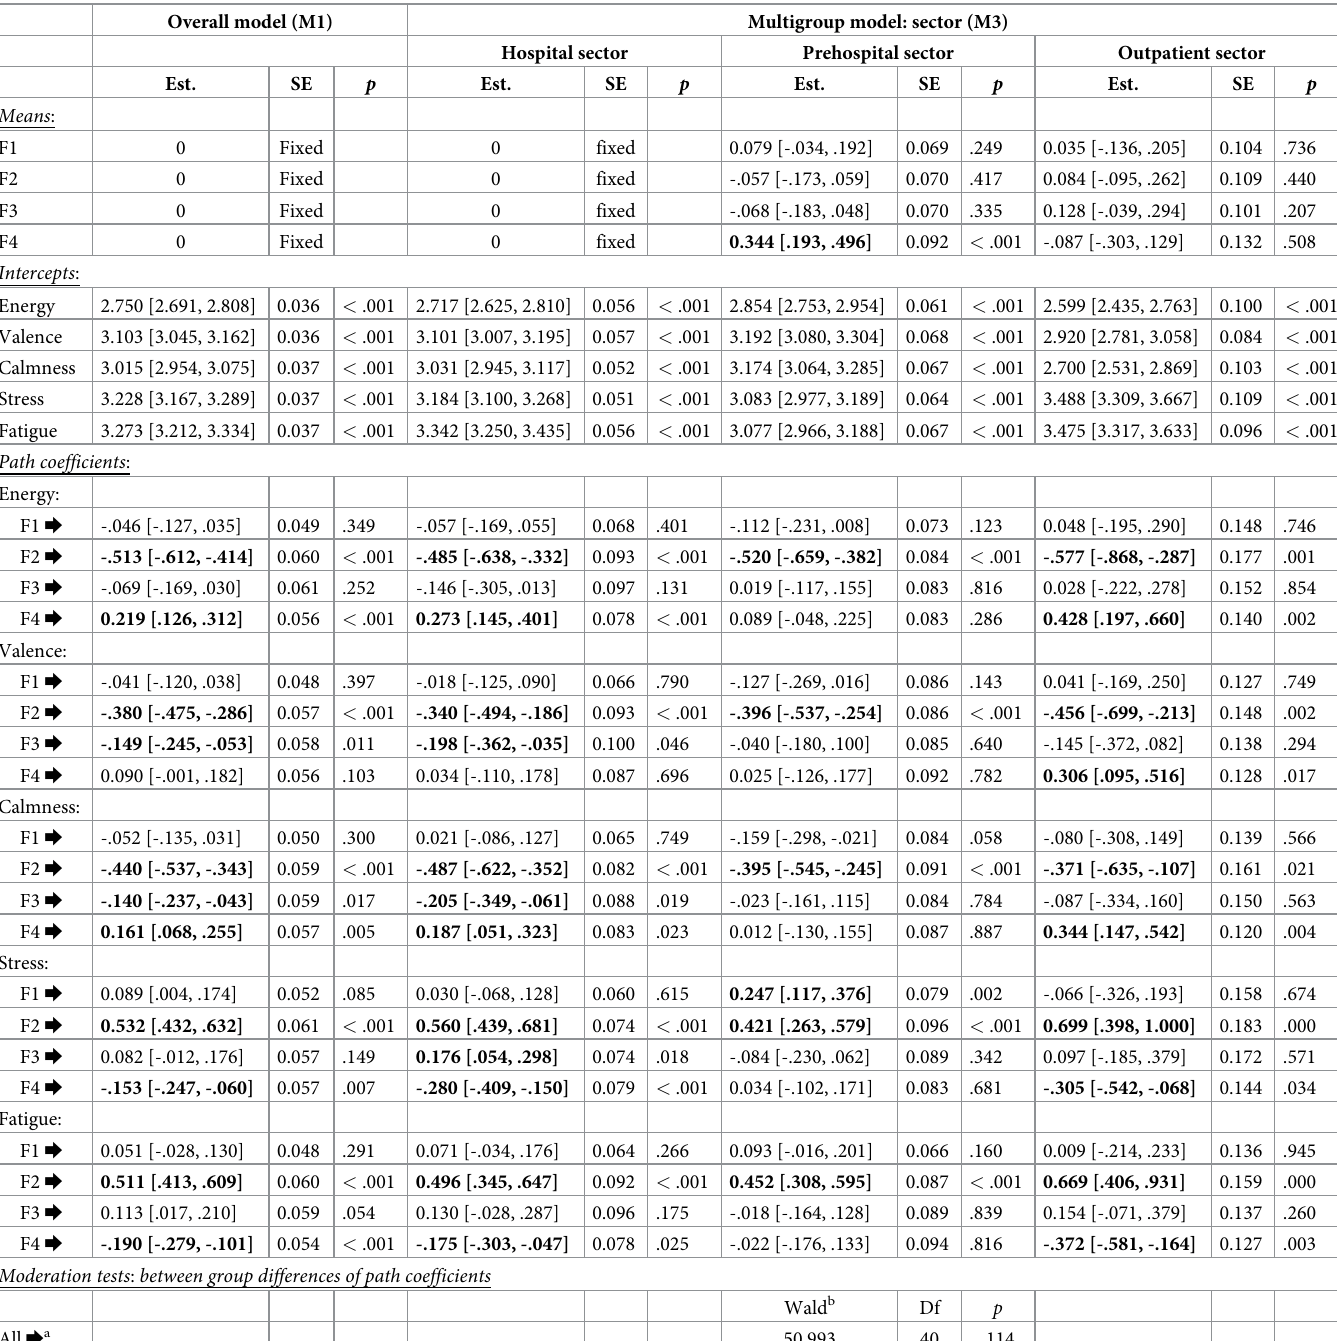
Table 2. Structural equation model results: estimates of factor means, intercepts, and path coefficients from models 1 and